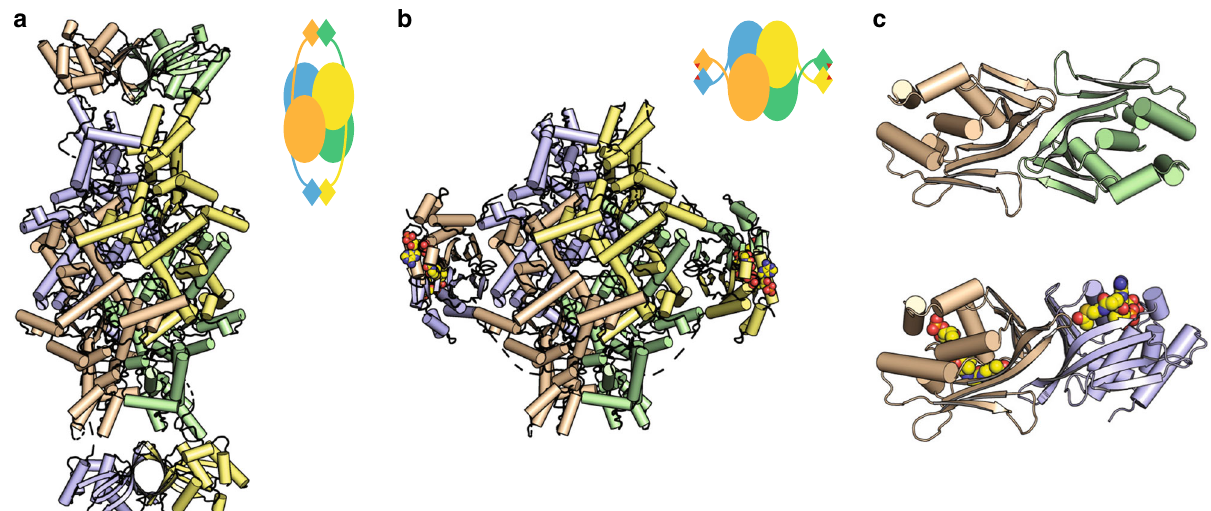
Fig. 1 Structure of ICL2. a Ligand-free ICL2 forms an elongated structure with C-terminal dimers at each end of the structure. b Striking structural rearrangement of ICL2 upon binding to acetyl-CoA. In both a and b , each monomer is shown in different colours and the schematics outline the structural features of the tetramer in each case. c The dimeric association of the C-terminal domains in the ligand-free (top) and acetyl-CoA-bound (bottom) ICL2. Acetyl-CoA is shown as spheres in panels b and c . Both panels are shown with the same orientation of the wheat-coloured